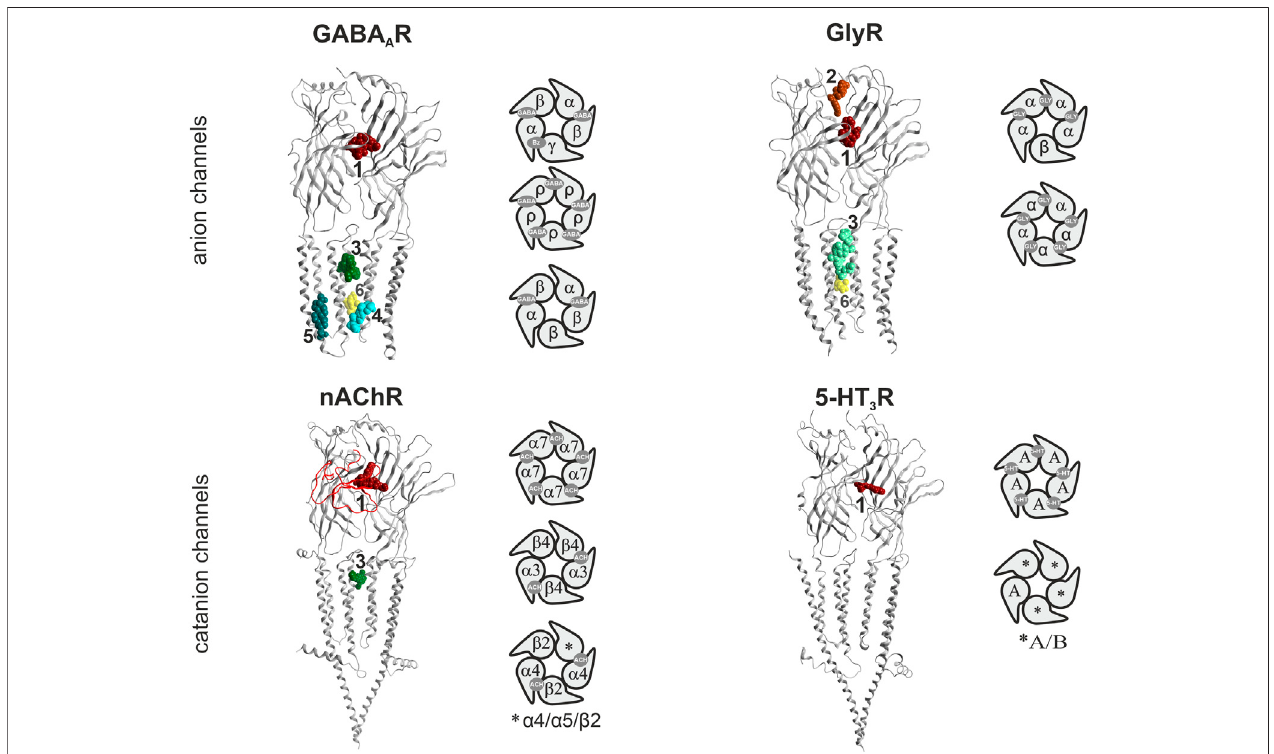
FIGURE1| BindingsitesinpLGICs.ForeachpLGICfamily,onerepresentativesubunitdimerisdisplayed asribbonstructure,insuperpositionwithselectedligand bound structures. The superposition of multiple ligands (where available) serves to give an impression of the overall volume of the pockets. The displayed structures are asfollows: GABA A Rs: ribbonand picrotoxin(yellow, channel blocker site 6): 6X40;canonicalECD site1(red inallpanels): superpositionofdiazepam/6HUP, bicuculline/ 6X3S, fl umazenil/6X3U;upperTMDinterfacesite3(greenshadesinallpanels):etomidate/6X3Vandpropofol/6X3T;lowerTMDinterfacesite4(cyan):alphaxalone/ 6CDU; TM3/TM4- lipid associated site 5 (ocean blue): pregnenolone sulfate/5OSC. GlyR: ribbon and glycine in canonical ECD site: 5BKG; upper ECD interface site 2 (brown): AM-3607/5TIO; site 3: ivermectin/5VDI; channel blocker site 6: 6UD3. nAChR: ribbon with alpha-bungarotoxin at site 1 in red tube: 7KOO, site 1: varenicline/ 6UR8 and EVP-6124/7EKT, site 3: PNU-120596/7EKT. 5-HT 3 R: ribbon and site 3 granisetron/6NP0. Next to the ribbon renderings, some representative pentameric arrangements are shown schematically. For each family, the binding sites for the orthosteric agonists, and the high af fi nity benzodiazepine site (Bz) of GABA A receptors are displayed in the selected pentameric